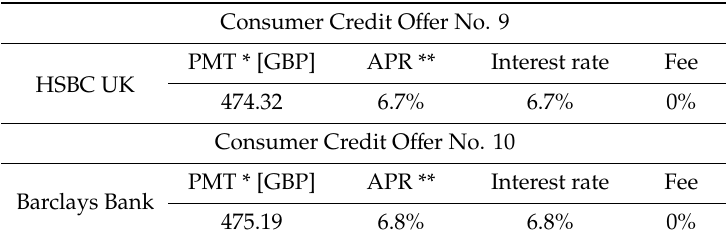
Table 2. Actual consumer credit o ff ers: two examples. Terms of credit: amount of credit: 20,000 GBP, 48 monthly repayments (Constant